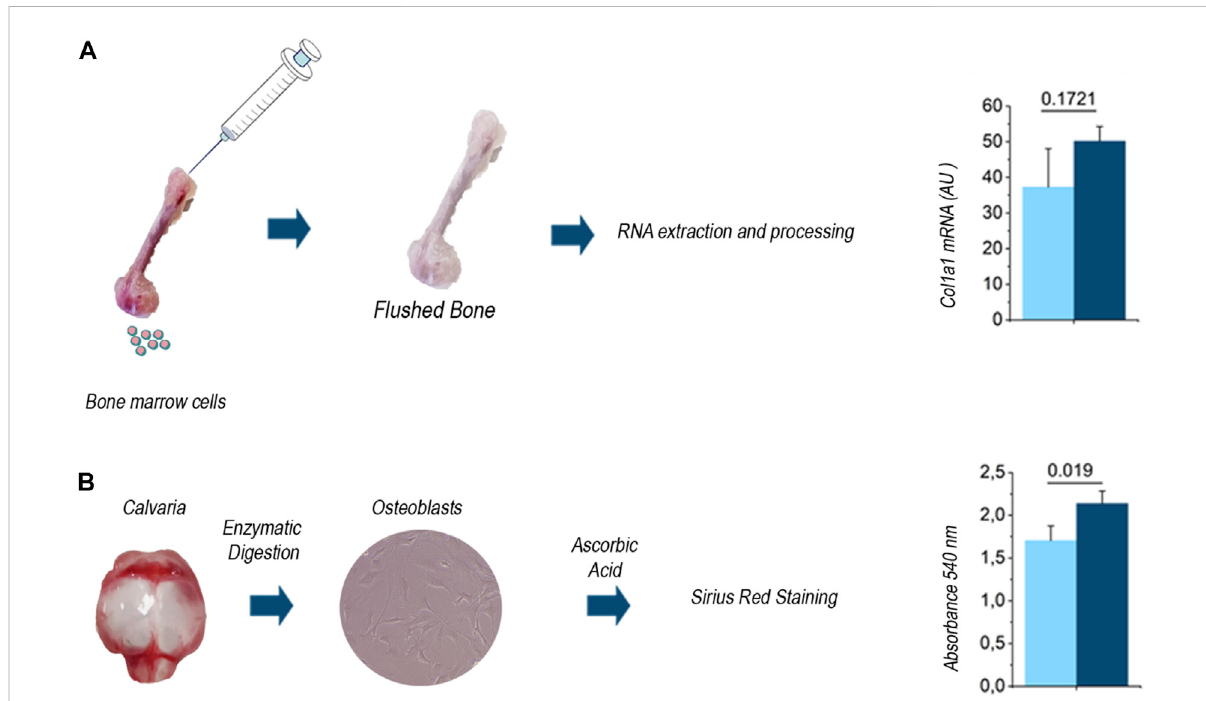
FIGURE 5 (A) Schematic representation of the tissue processing for RNA extraction and quantization of ColIa1 gene expression level in the WT and Dpp3 KO ( n = 4 WT and n = 7 KO). (B) Schematic representation of the procedure for primary osteoblast isolation from WT and Dpp3 KO neonatal calvaria,andassessmentof invitro collagenproduction( n =4WTand n =6KO).StatisticalanalysiswasperformedusingMannWhitneytest; p values are indicated above each bar